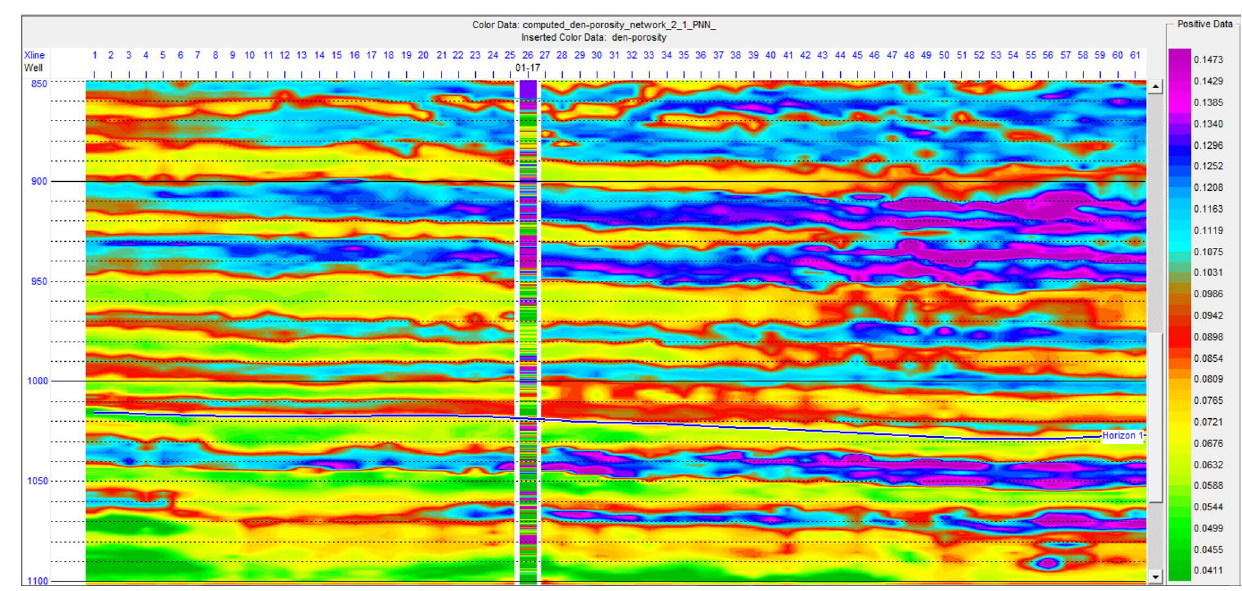
Fig. 20 Porosity obtained from the PNN network applied to the second category data at one section, and to the desired well parameters